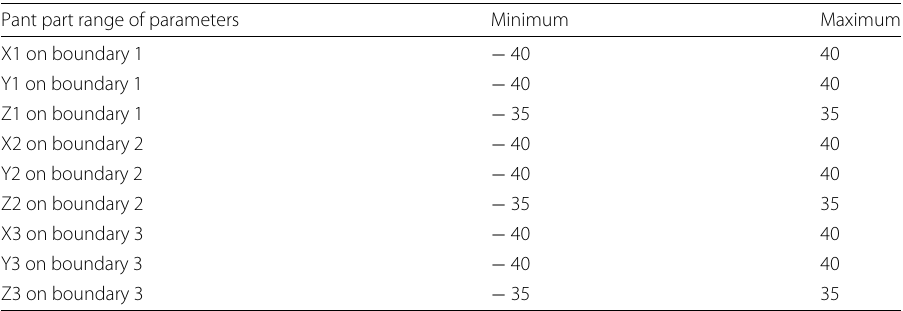
Table1 Range of parameters used for the T-shape part geometric reduced order model Pant part range of parameters Minimum Maximum X1 on boundary 1 − 40 40 Y1 on boundary 1 − 40 40 Z1 on boundary